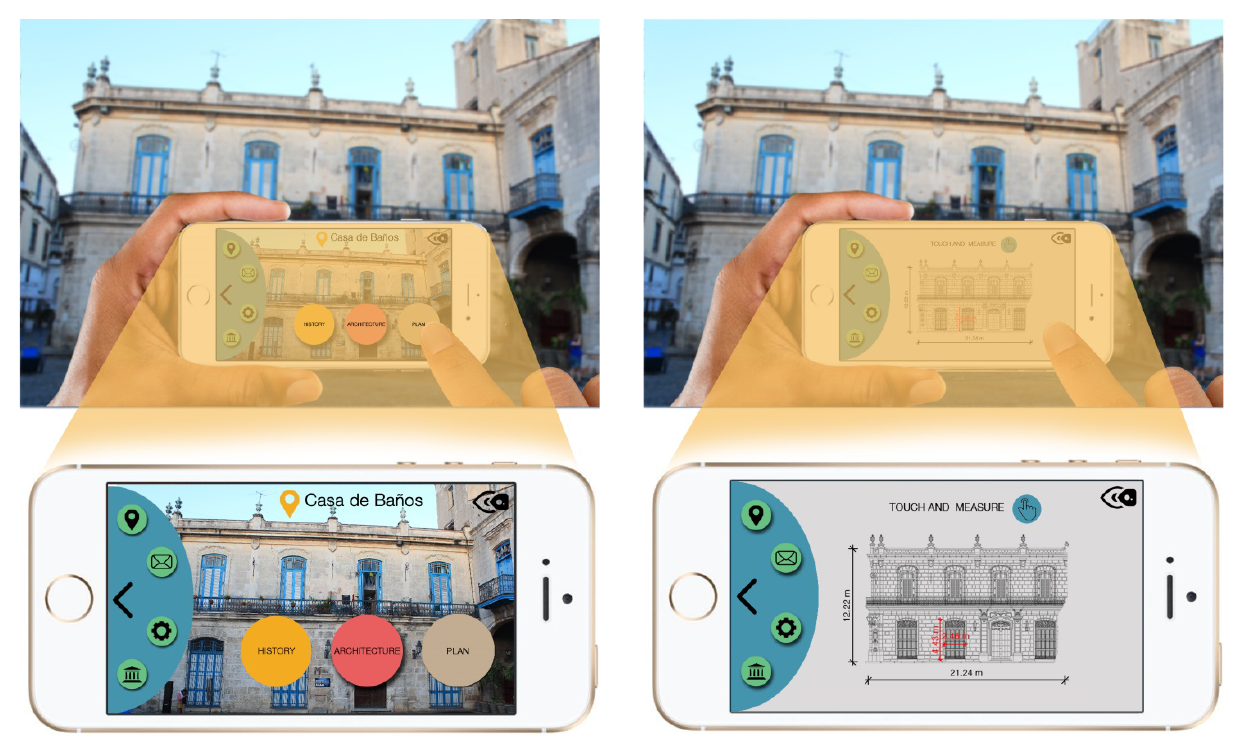
Figure 7. Example of an application of aumented reality (Casa de Baños - Plaza de la Catedral)